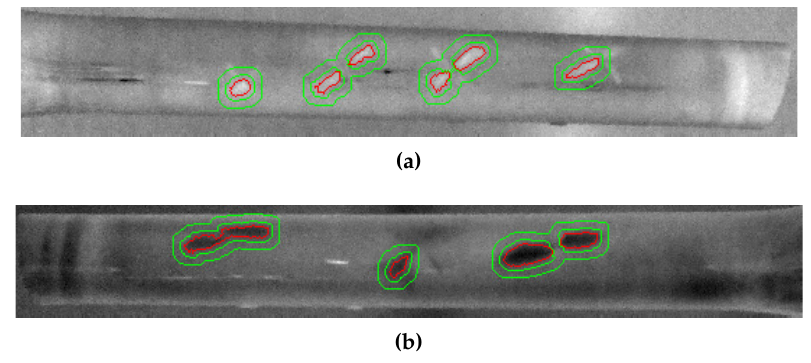
Figure 8. Defect and sound regions for the quantitative evaluation of the results. ( a ) Side A (from left to right, impact damage of 3, 4, 5 and 6 J). ( b ) Side B (from left to right, impact damage of 7, 8 and